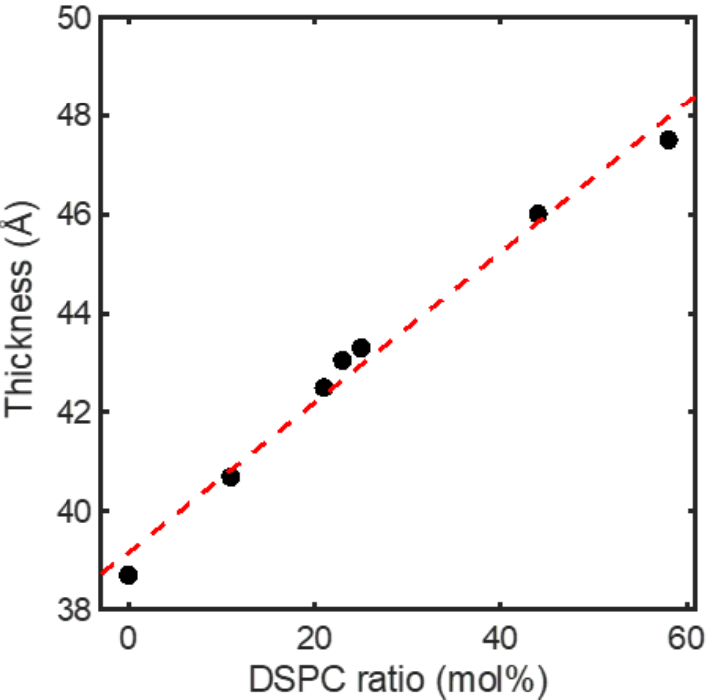
Figure 5. Membrane thickness determined with SAXS for the homogeneous membranes as a func- tion of composition at 23 °C. The compositions are designated by their DSPC contents. Detailed compositions are given in Table 1. Dashed line is a linear fit to guide the eyes.